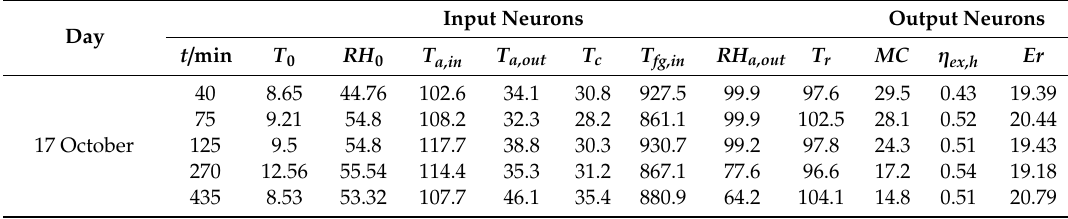
Table 3. Partial experiment data and the related calculation